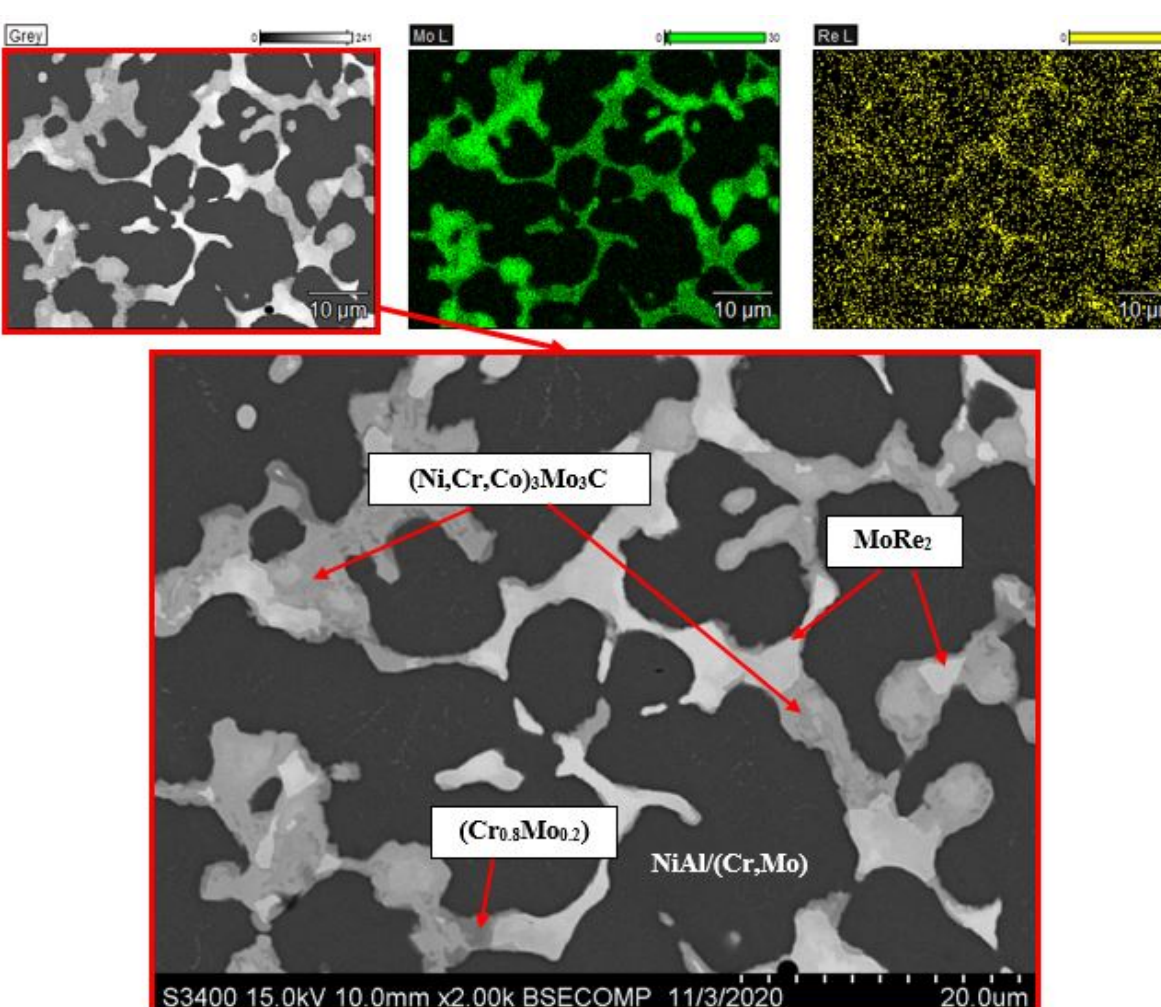
Figure 12. The microstructure of the alloy doped with 15% Mo and 1.5% Re and the map of dopant distribution.